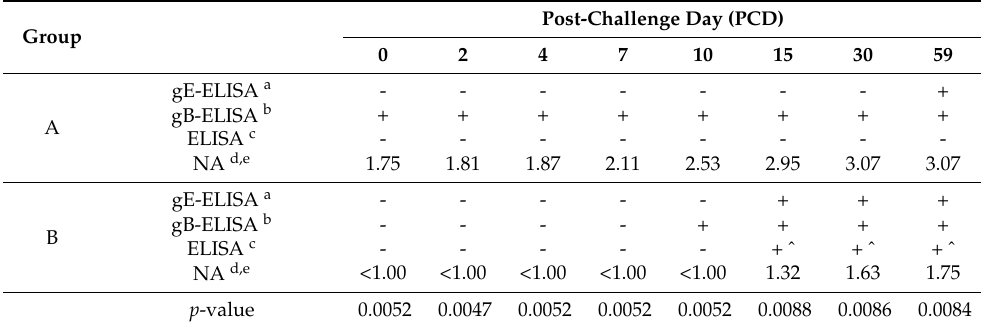
Table 3. Antibody response of water buffaloes immunized against BoHV-1 using an inactivated gE-deleted marker vaccine and challenge infected with virulent